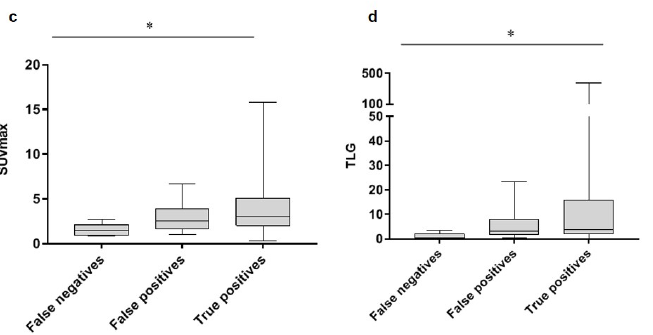
Figure 2. SUV max and TLG show no significant differences between false and true positive lesions . Lesions were classified into 3 groups, i.e. false negatives, false positives and true positives; lesions have been verified with pathology (a/b) or additional imaging and/or follow-up (c/d). Similar results have been obtained for SUV peak and SUV mean (Supplementary Figures S1 and S2). * p